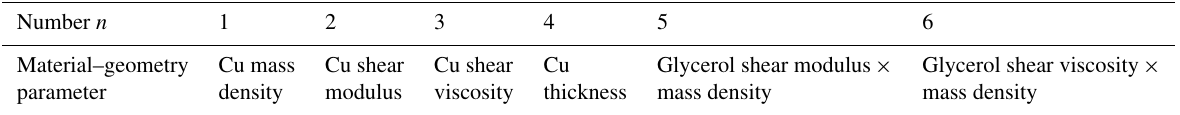
Figure 5. (a) Mapping of the elements of the Jacobian matrix J mn defined in Eq. (40) with varying measurement index m from 1 to 56 and material parameter index n from 1 to 6. The overtone number runs from 1 to 16. The material system is an AT-cut quartz plate with a 5µm thick Cu layer and a glycerol half-space. Order at each material–geometry parameter value: resonant–anti-resonant frequencies and resonant–anti-resonant FWHMs. (b) Mapping with enlarged sensitivity range around zero, at material parameter 3 (Cu viscosity) and 6 (glycerol viscosity × mass density) for the resonant frequencies and at material parameter 5 (glycerol shear modulus × mass density) for both resonant frequencies (left) and FWHMs (right). Table 2. Numbering n of material–geometry